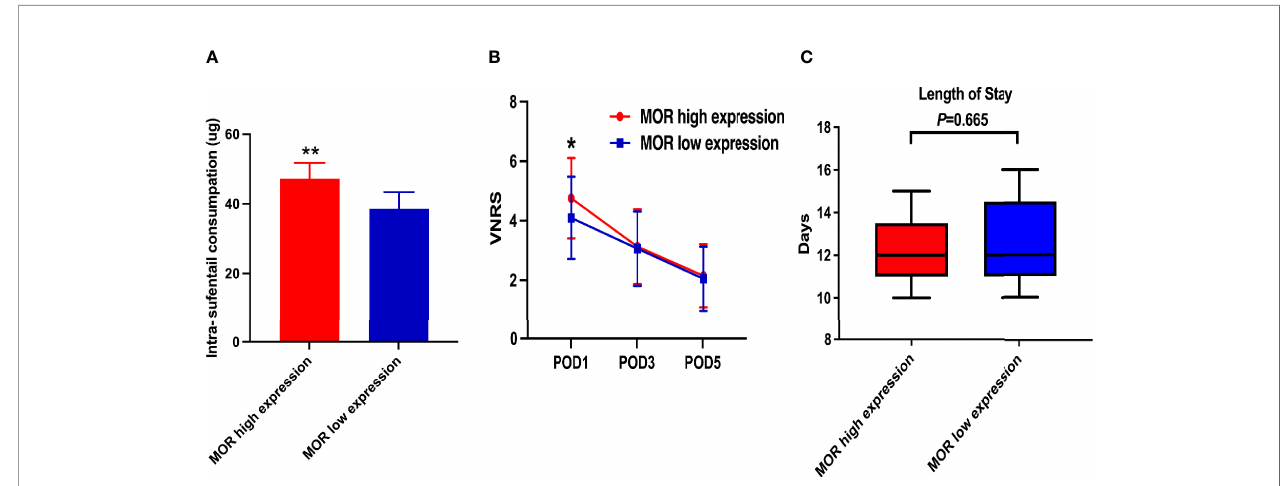
FIGURE 2 | Secondary outcomes of the study. (A) Intraoperative sufentanil consumption according to MOR expression; (B) VNRS on POD1, POD3, and POD5 according to MOR expression; and (C) LOS according to MOR expression. MOR, mu-opioid receptor; VNRS, verbal numerical rating scale. * P < 0.05, ** P < 0.01.